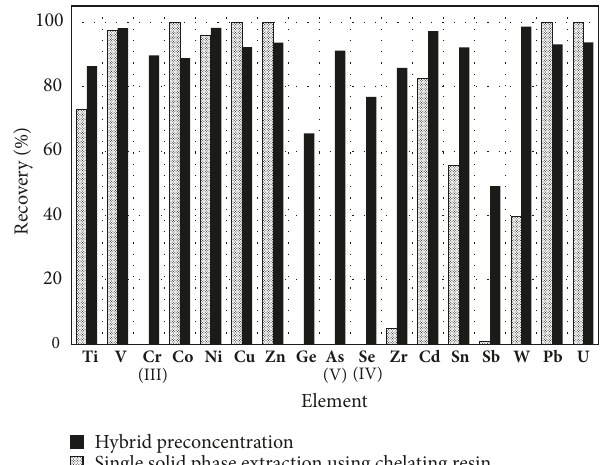
Figure 2: Comparison of the recoveries of Cr, As, Se, and other trace metal elements by the hybrid preconcentration with those by single preconcentration using chelating resin.